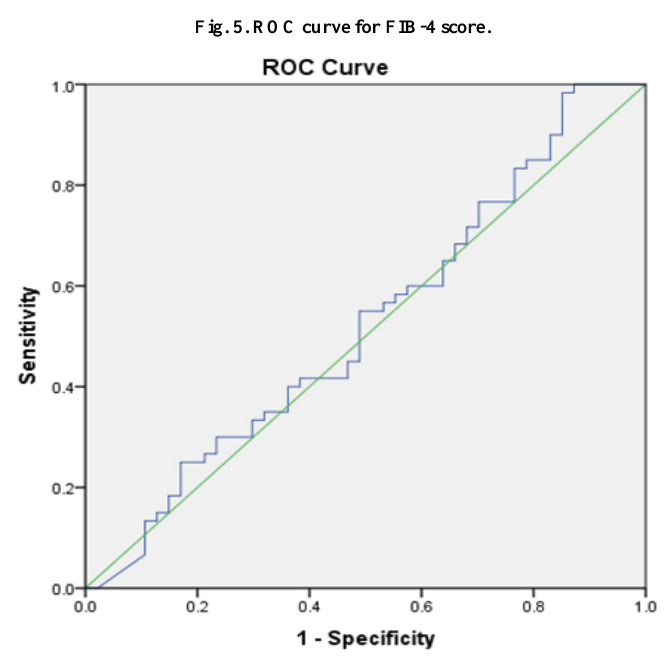
Fig. 6. ROC curve for King’s